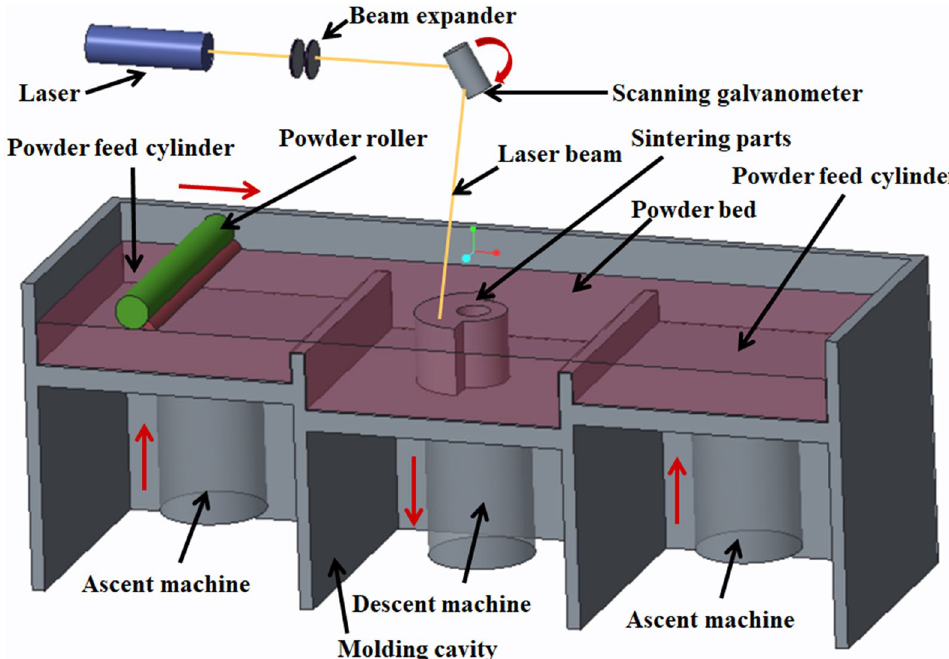
Figure 2 Forming principle